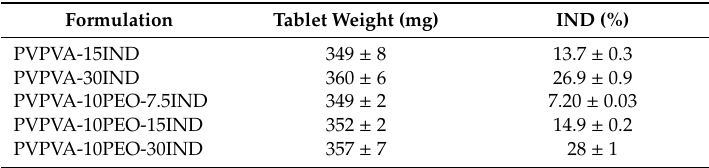
Table 3. Uniformity of weight and IND content of tablets fabricated using µ IM.